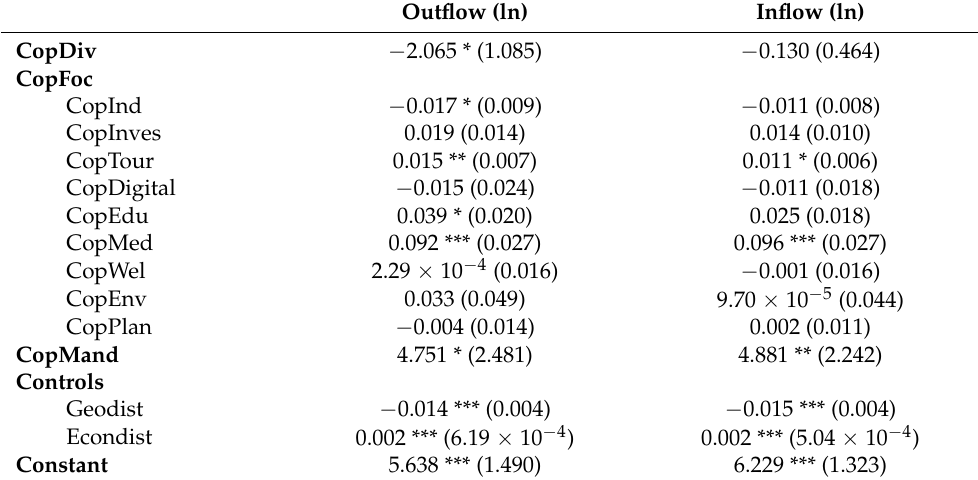
Table 2. Regression results of population flow under the Mountain-Sea Cooperation